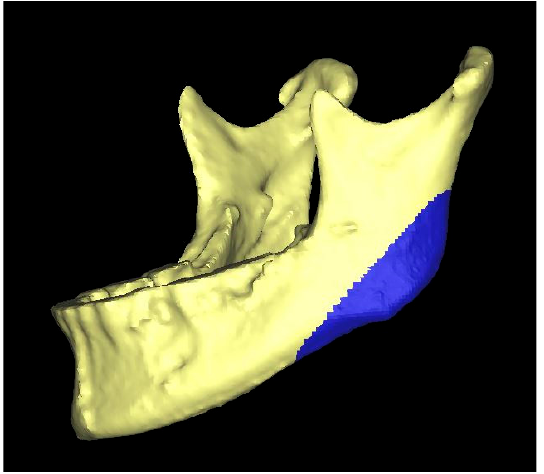
Figure 2. Three-dimensional representation of the mandibular bone. The blue surface is the area which was selected in order to align (i.e., superimpose) the original ( left ) and mirrored ( right ) mandibular angle.